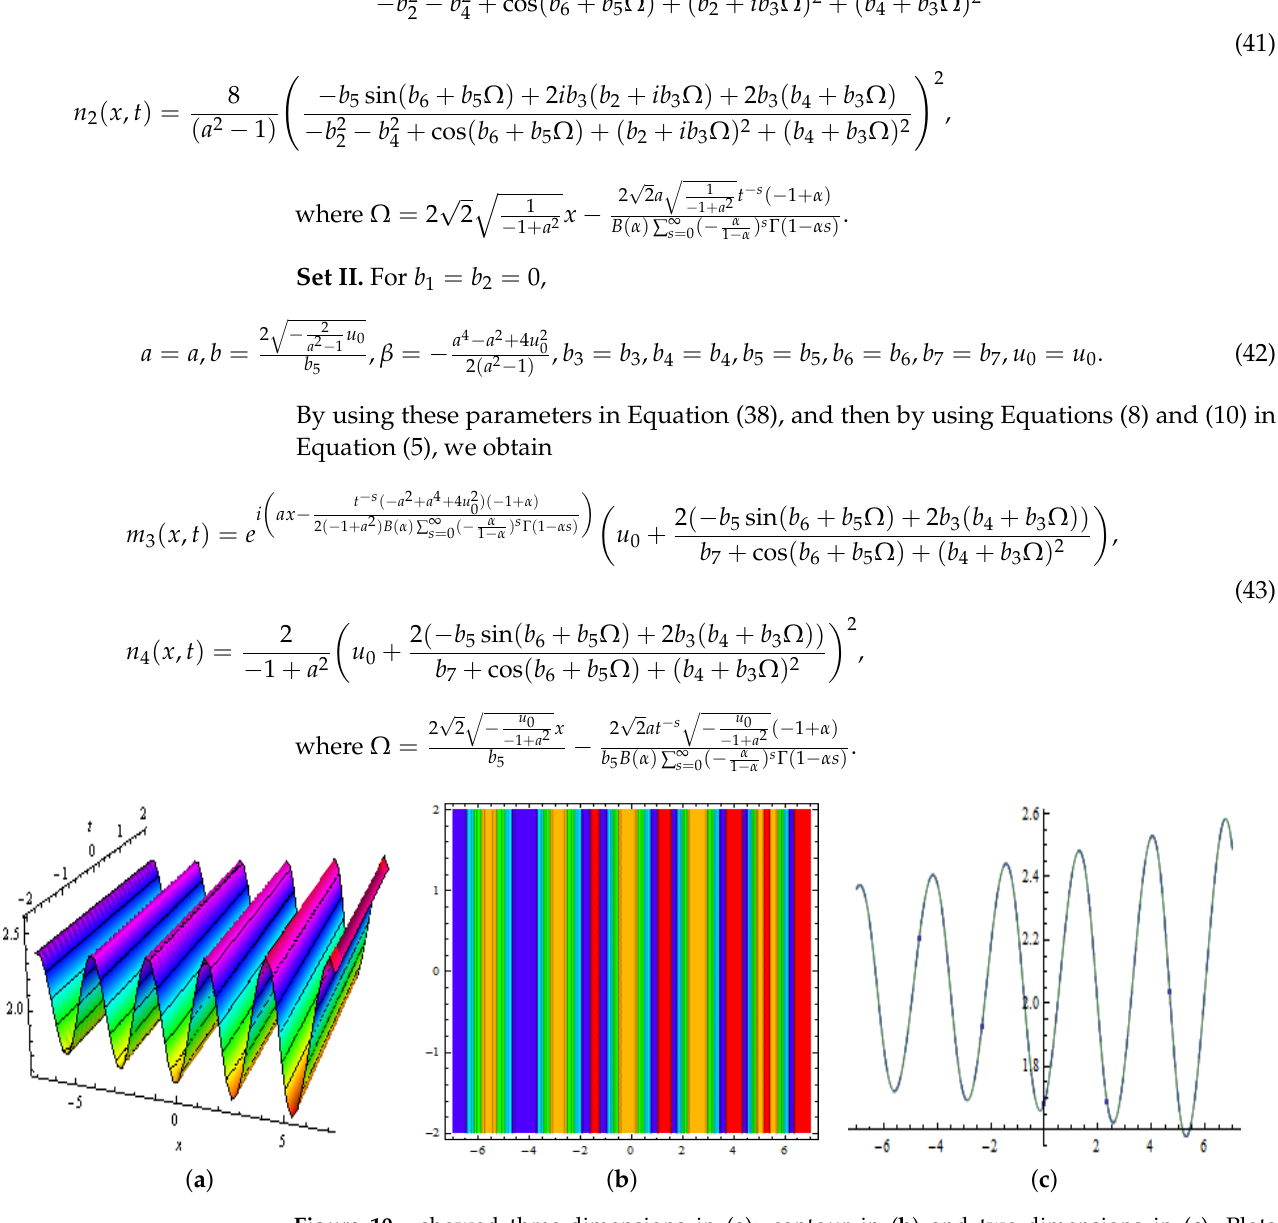
Figure 10. showed three-dimensions in ( a ); contour in ( b ) and two-dimensions in ( c ), Plots of m 3 ( x , t ) in Equation (43) at a = 2, u 0 = − 2, b 3 = 0.05, b 4 = − 3, b 5 = 2, b 6 = 5, b 7 = 1, α = 0.9,